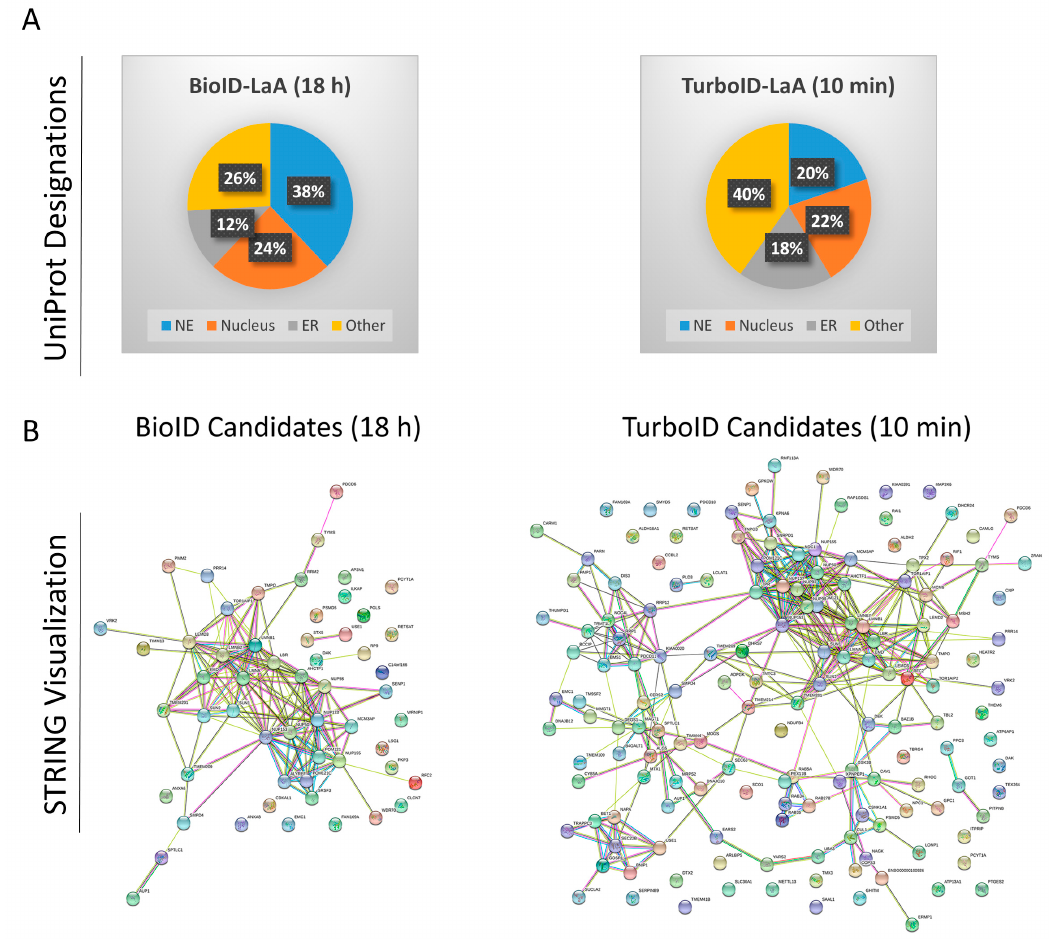
Figure 4. Post-pulldown proteomic analysis of LaA PPI candidates. ( A ) Following MS data analysis, Figure 4 BioID- and TurboID-LaA candidates were submitted to UniProt using the “Retrieve / ID Mapping” tool and subsequently grouped by subcellular domain designations. ( B ) Candidates were also submitted for STRING analysis